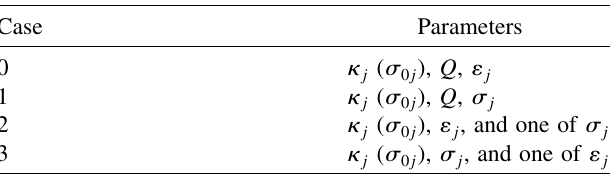
TABLE I. Possible parametrizations of matched envelope so-